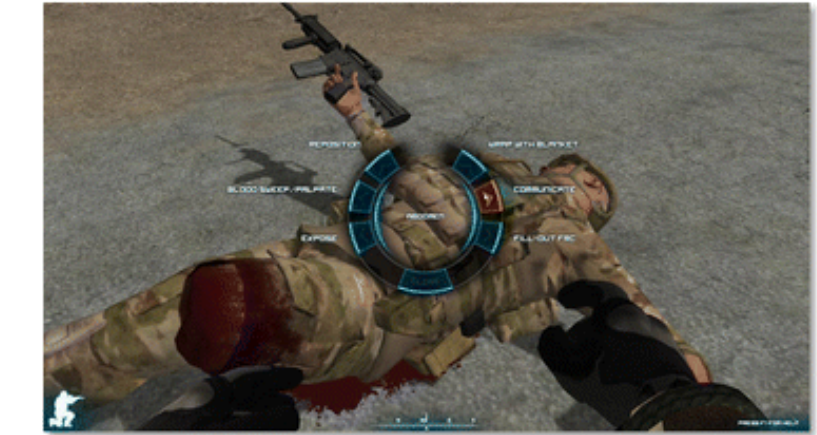
Figure 9 – Screen-shot of the TC3Sim game (Hussein and Coleman, 2015) Рис . 9 – Изображение из игры TC3Sim (Hussein and Coleman, 2015) Слика 9 – Приказ у оквиру игре TC3Sim (Hussein and Coleman,